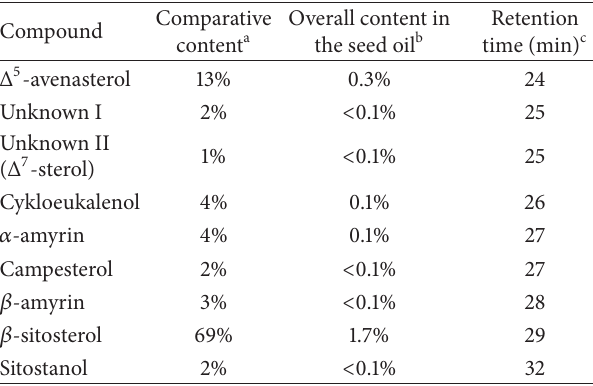
Figure 5: SEC-NMR measurement of the sea buckthorn extract samples, leaves (a), seed oil (b), and seed coat (c). FFA: free fatty acid, TG: triglycerides, FS: free phytosterols, and CS: conjugated phytosterols. Table 1: Composition of the saponified sea buckthorn seed oil determined by